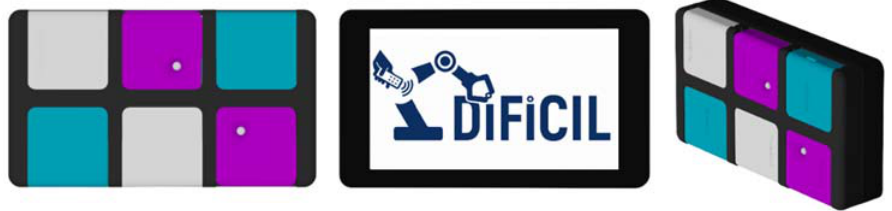
Figure 1. The assembled product from front, back, and perspective.